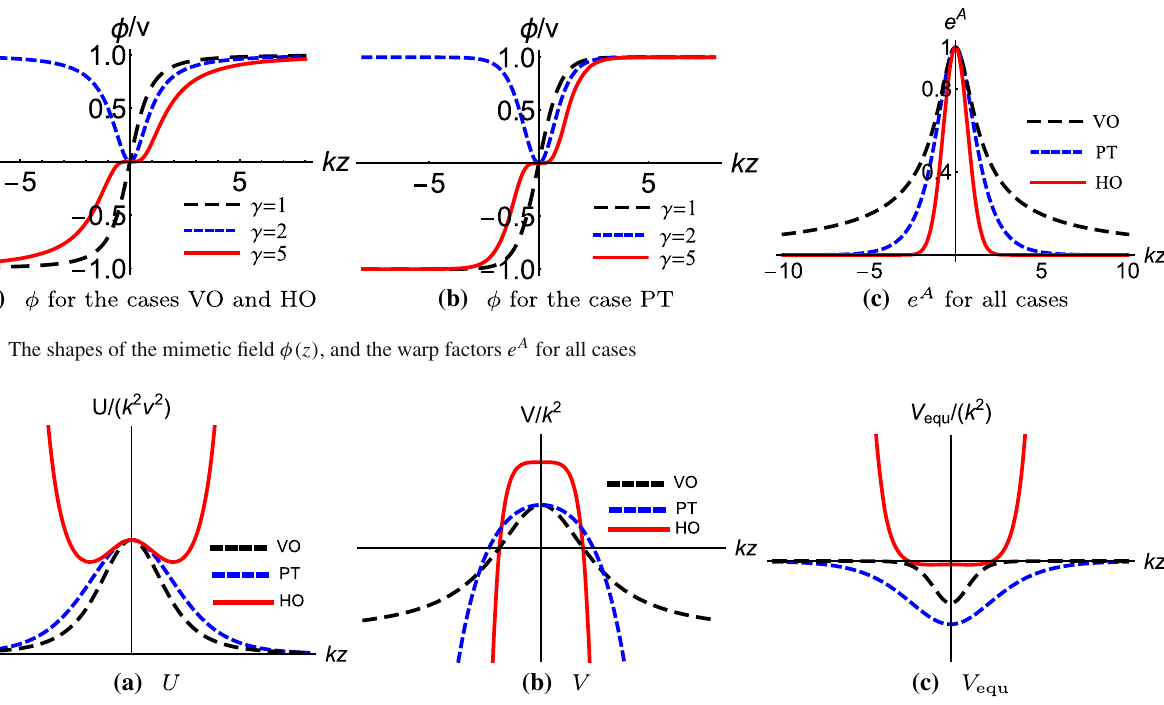
Fig. 3 The shapes of the scalar potentials U (φ) and V (φ) from the action, and the equivalent potential V equ for the canonical version of the mimetic